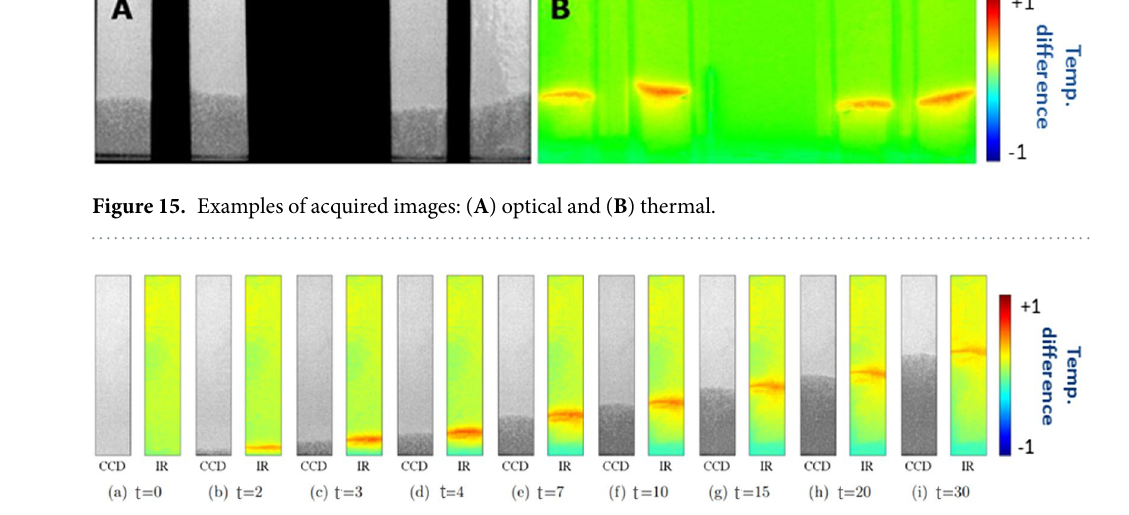
Figure 16. Optical and thermal images of RL 200 paper during spontaneous imbibition at various times